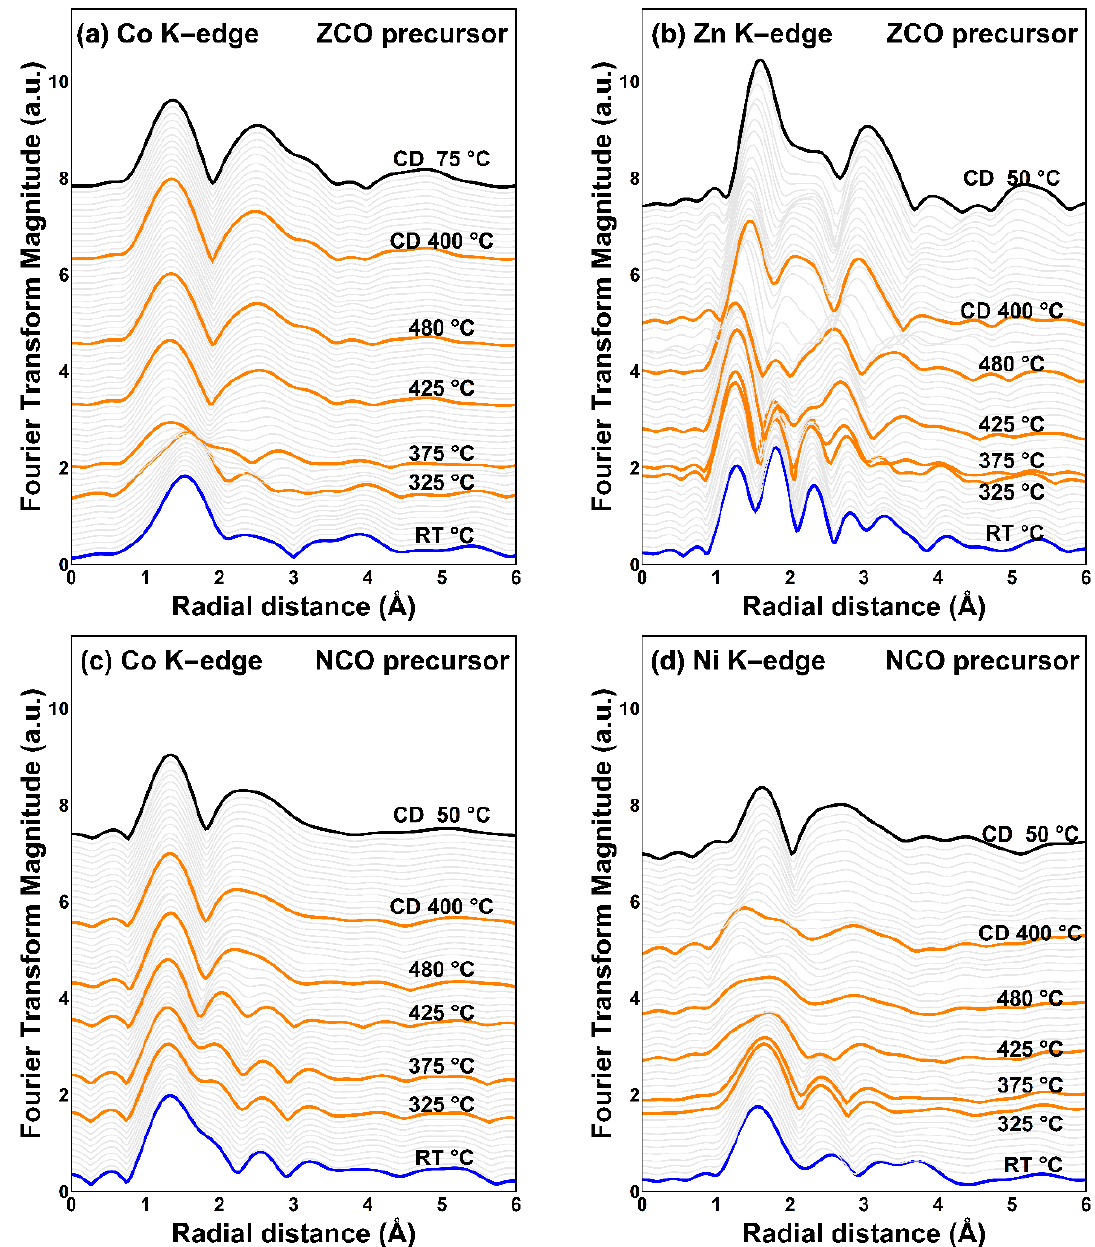
Figure 6. Fourier transform of TRXAS K-edge EXAFS region of metals in two different spinel precursors; ( a ) cobalt and ( b ) zinc in the ZCO precursor; ( c ) cobalt, and ( d ) nickel in the NCO precursor.